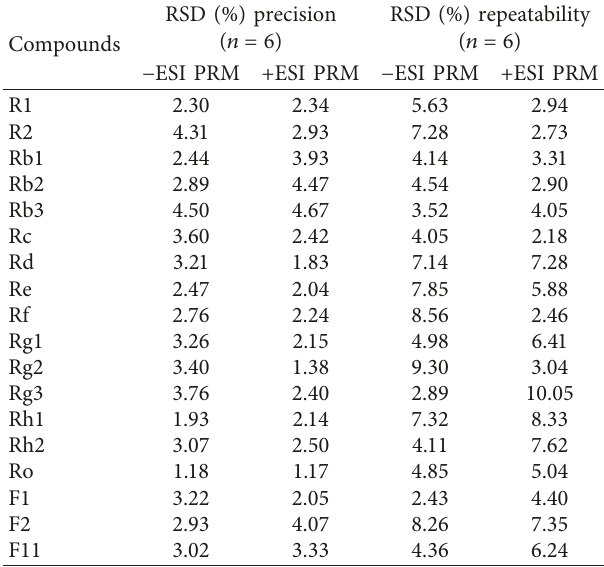
Table 4: Precision and repeatability for the eighteen ginsenosides in ginseng stem-leaf.